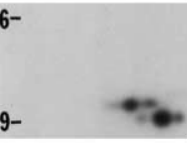
Two-dimensional gel electrophoresis of human SP-A precursor molecules and native SP-A from bronchoalveolar lavage (BAL). The two precursor molecules (major spots) of 29 and 31 kDa [23] and their isoforms (minor spots), which are due to acetylation, are depicted in the left panel. Cotranslational and posttran- scriptional modifications (listed in the middle) of the precursor molecules, give rise to native SP-A consisting of multiple isoforms in molec- ular weight and isoelectric points shown in the right panel (monomers at ~35 kDa, dimers at ~60–65 kDa